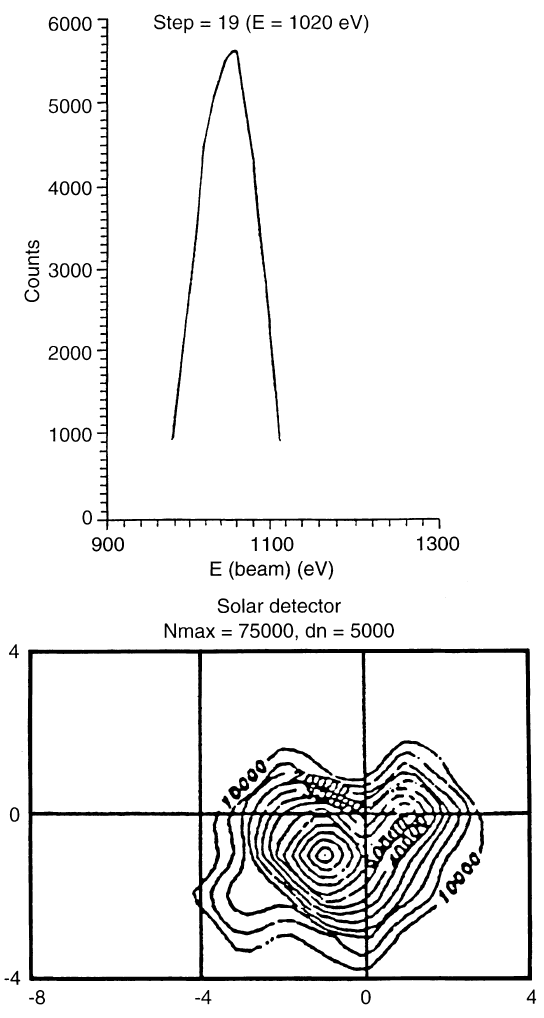
Fig. 3. Examples of energy ( above ) and angular ( below ) diagrams of EU-1